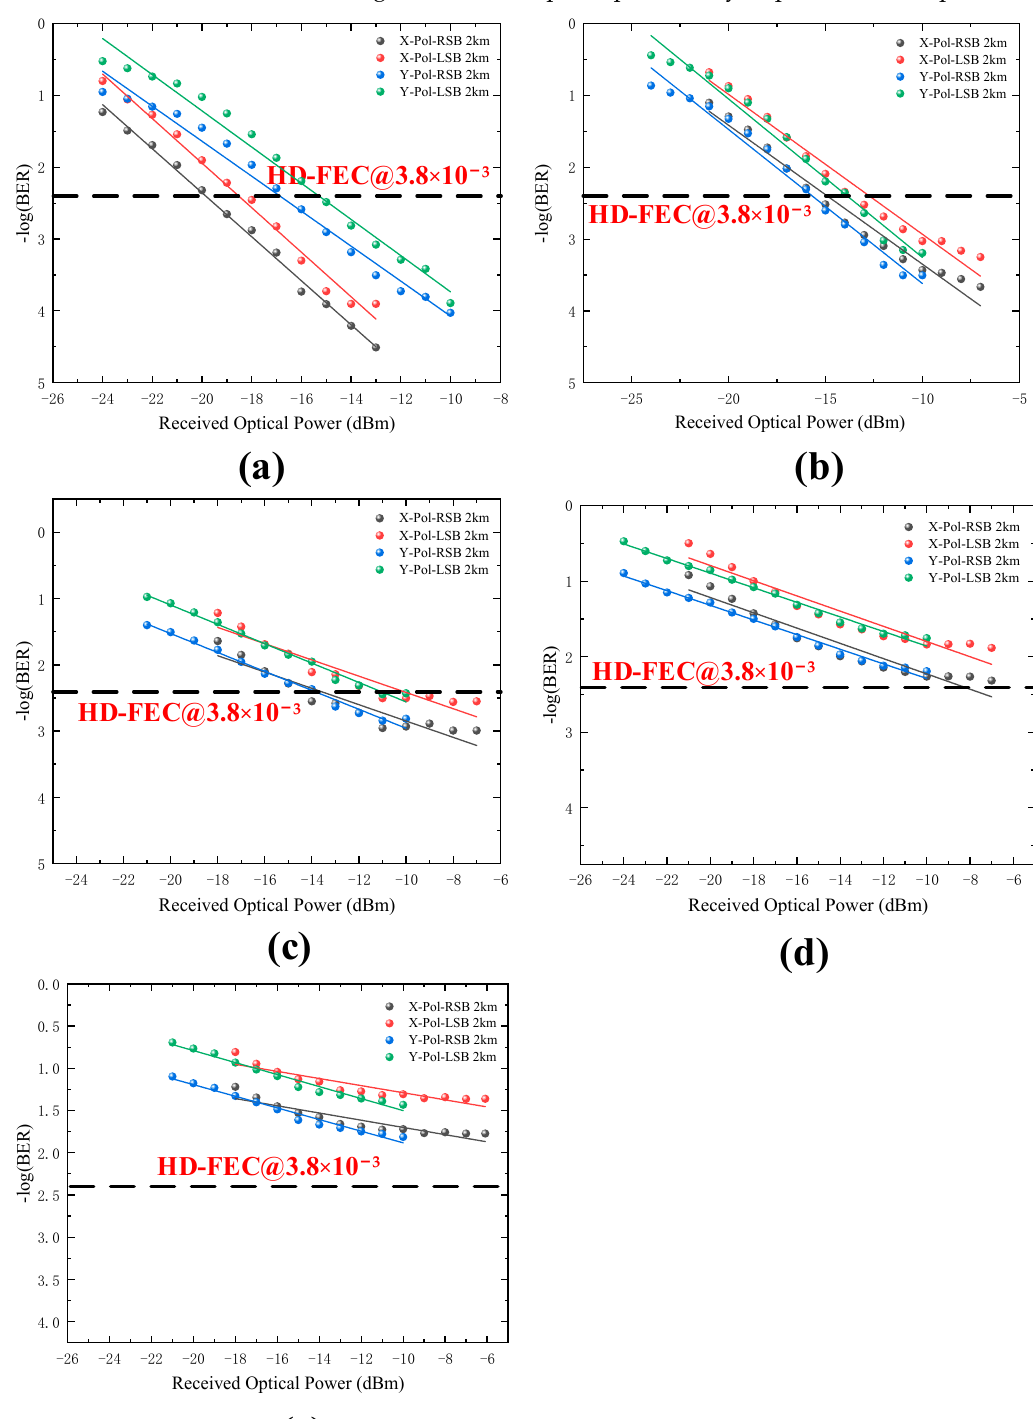
Figure 5. BER versus the received optical power for different baud rates at 2 km transmission scenario. ( a ) 8-Gbaud, ( b ) 10-Gbaud, ( c ) 12-Gbaud, ( d ) 14-Gbaud, ( e ) 16-Gbaud.